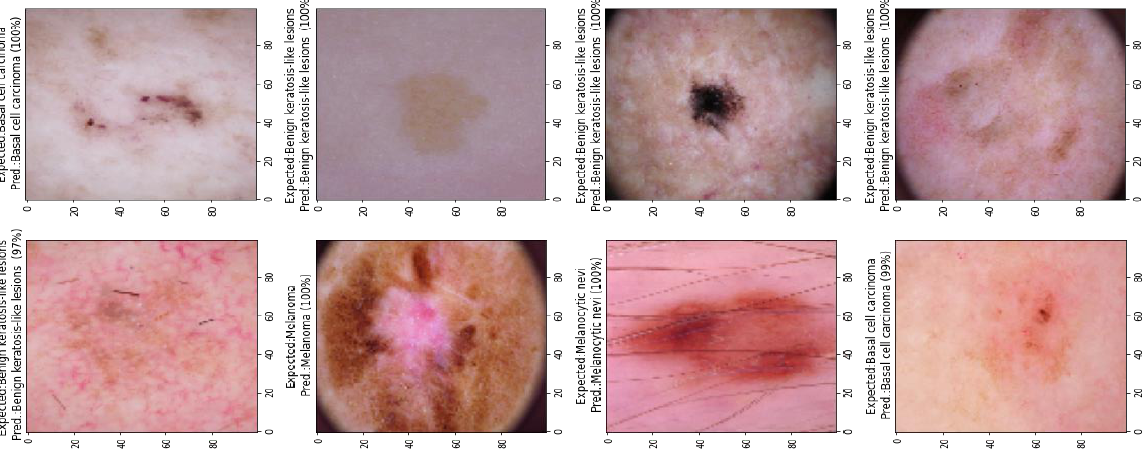
Figure 16. A visual example of classification results of the proposed ShuffleNet-Light model in